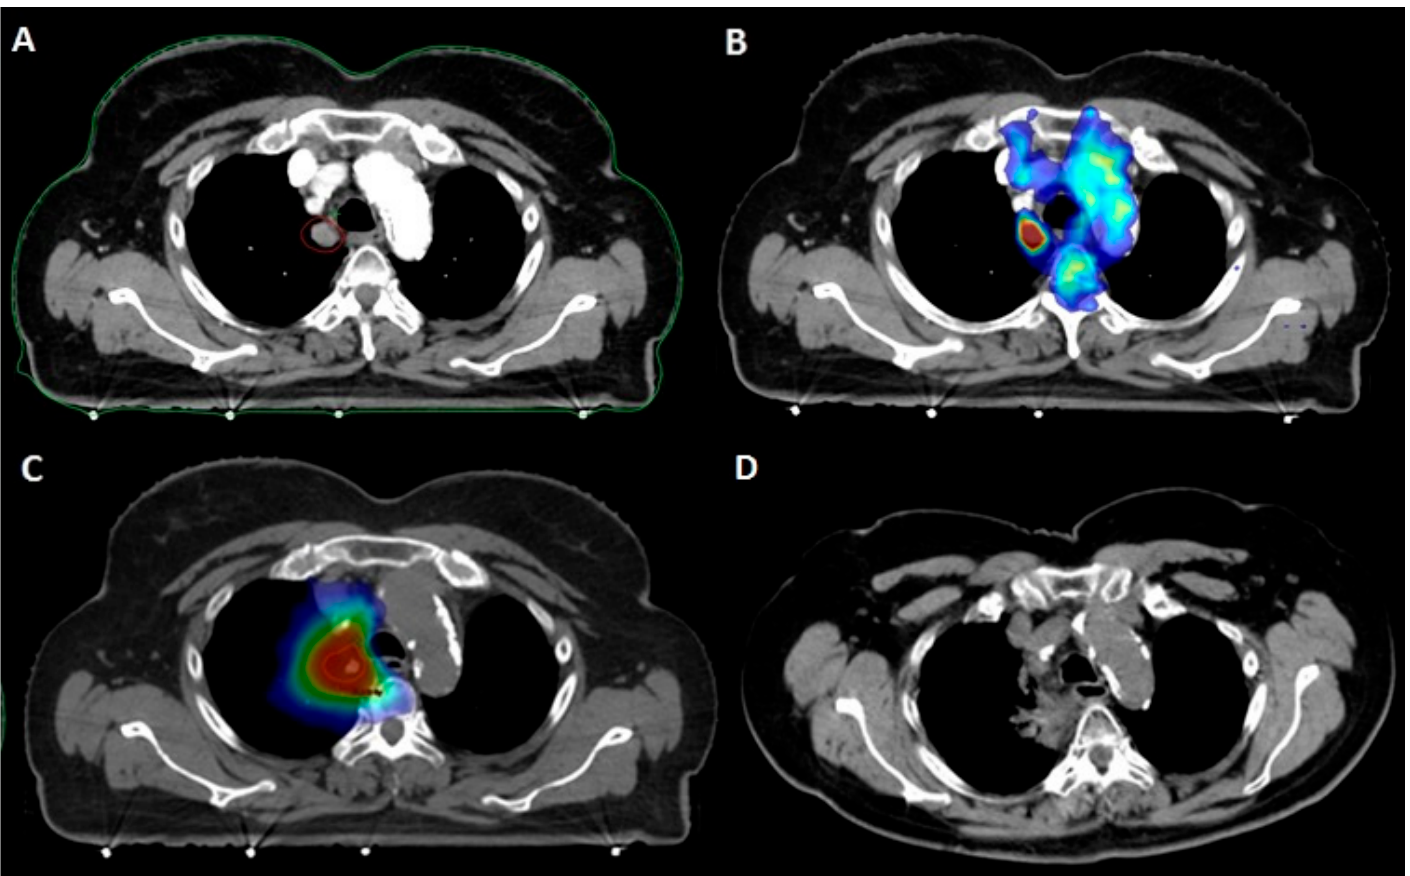
Figure 2. Patient with a clinical history of pT2N0 lung adenocarcinoma treated with upper lobe lobectomy. A: Paramediastinal middle lobe metastasis (12 × 13 mm) detected at follow-up contrast-enhanced chest CT. B: 18FDG-PET/CT fusion showing isolated hypermetabolism of the paramediastinal metastasis . C: SBRT delivering 50 Gy in five fractions to the PTV (dark blue: 20 Gy; light blue: 30 Gy; green: 40 Gy; yellow: 45 Gy; red: 50 Gy). D: CT evaluation at nine months showing radiation fibrosis following complete metabolic response.